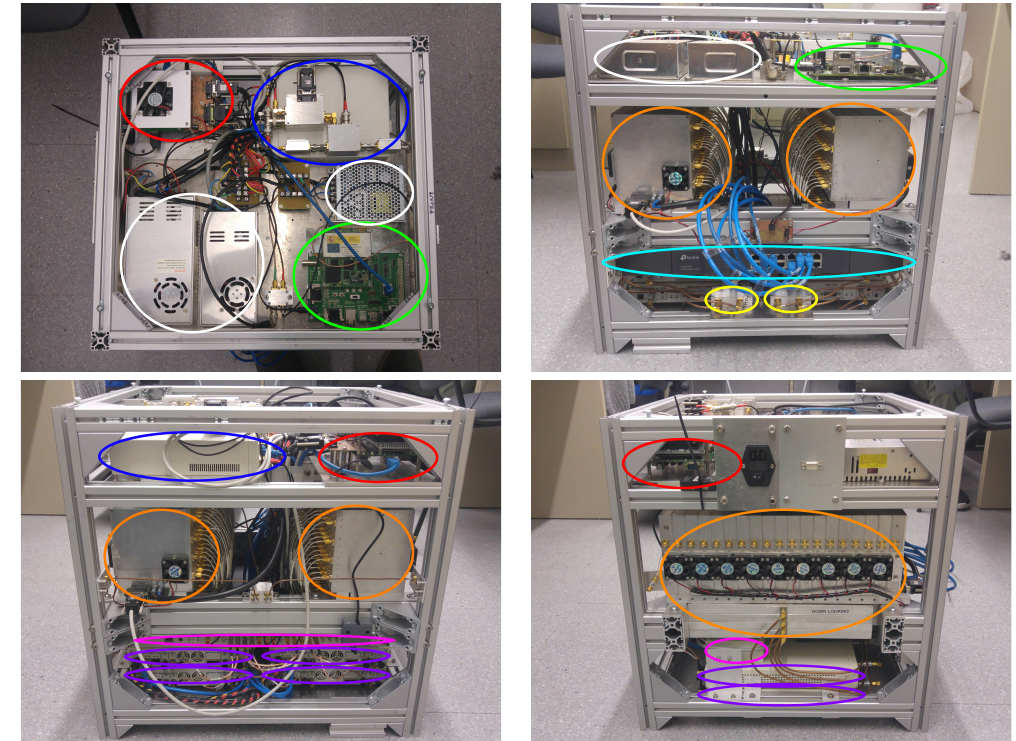
Figure 12. MIR rack. The top floor of the rack has the embedded system (red), the power supplies (white), the calibration system (blue), and the GNSS receiver (green). The middle floor has the beamformers (orange). The lower floor has the Octoclock (magenta), the SDR (purple), the gigabit ethernet swithc (cyan), and the extra amplifiers for the down-looking RF chain